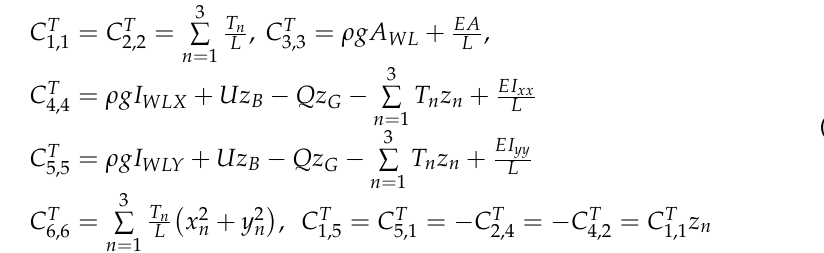
Table 6. REFOS stiffness coefficients, C T